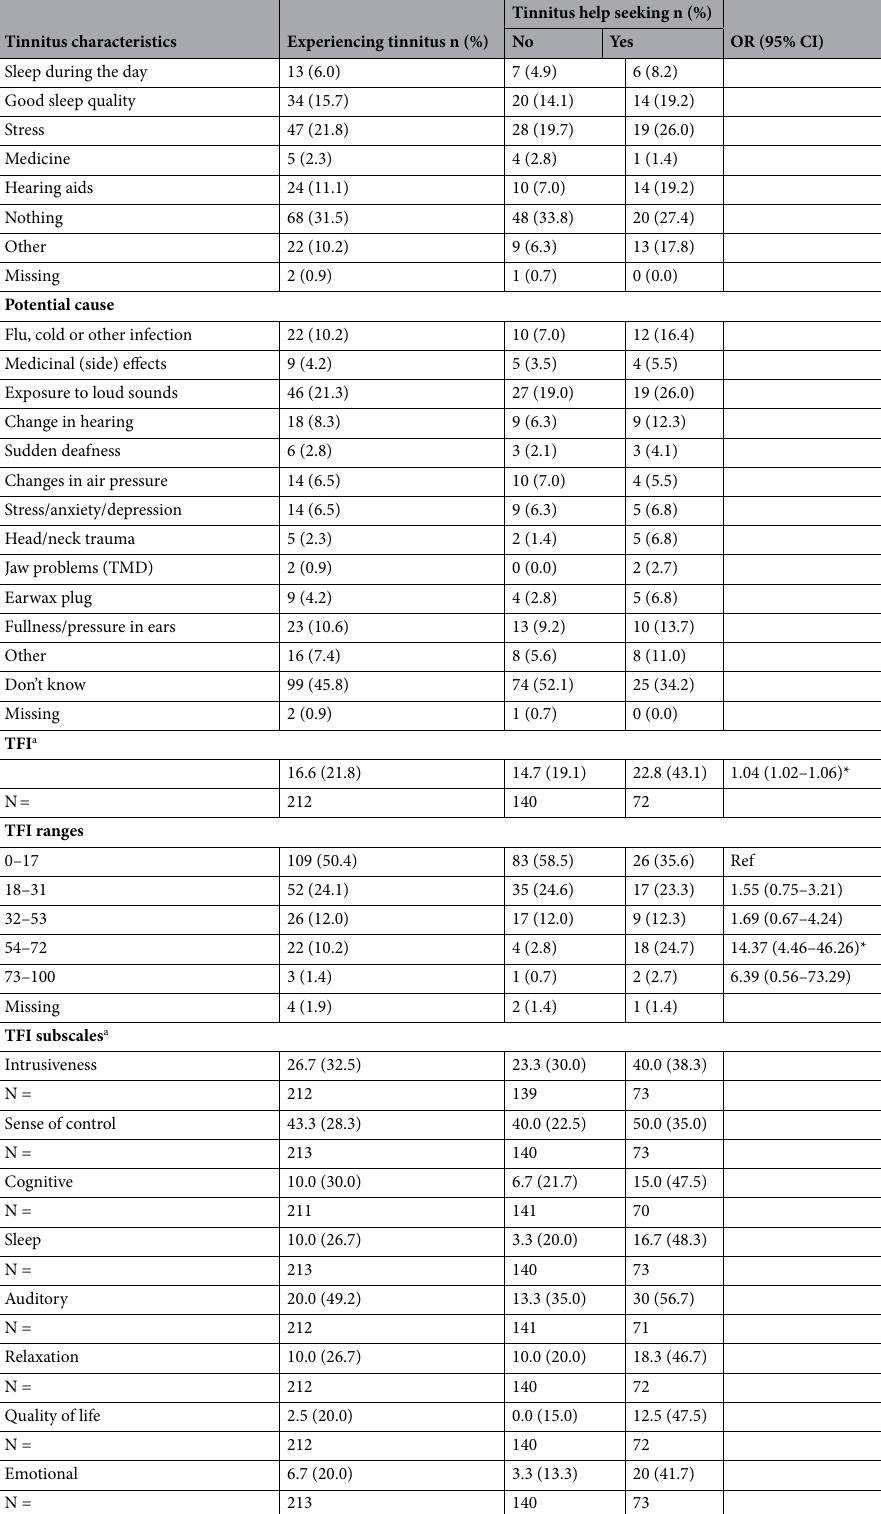
Table 3. Tinnitus characteristics. Please see Supplementary Table S2 for answer to location of tinnitus, other; influence of tinnitus, other; potential cause of tinnitus, other. a Median (IQR) * p < 0.05. b Both ears, more in the right ear. c Both ears, more in the left